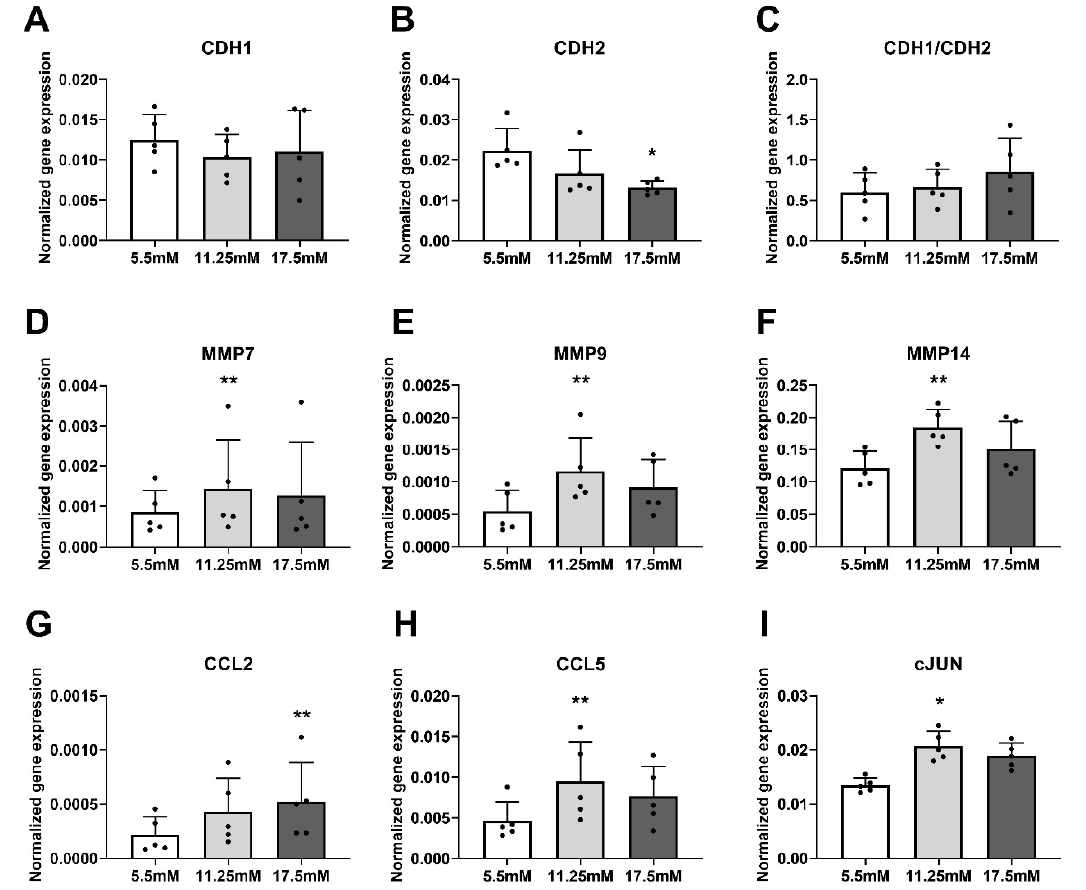
Figure 3. Gene expressions were quantified in 5.5, 11.25 and 17.5 mM glucose-treated PC3 cells (n = 5 independent experiments). ( A ) CDH1, ( B ) CDH2, ( C ) CDH1 / CDH2 ratio, ( D ) MMP7, ( E ) MMP9, ( F ) MMP14, ( G ) CCL2, ( H ) CCL5, ( I ) cJUN. Statistical significance was compared to 5.5 mM control samples using paired Friedman test with Dunn’s correction for multiple comparisons. Dots denote individual experimental values. Statistical significance was considered as p < 0.05 and indicated as * p < 0.05; ** p < 0.01.